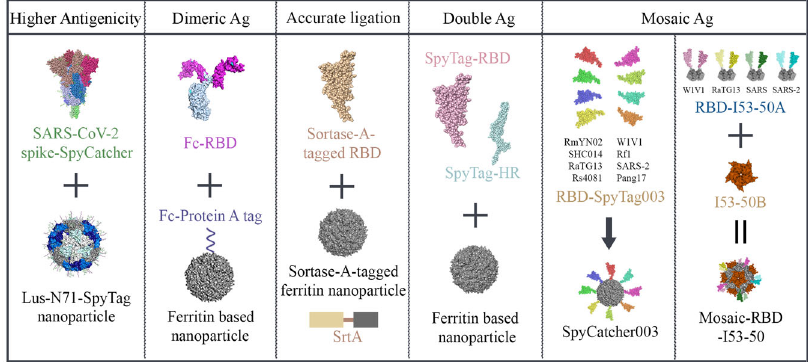
Fig. 4 Overview of antigens presented by nanoparticles. Plug-and-play platform increases the ef fi ciency of protein subunit vaccine production. Aquifex aeolicus lumazine synthase (LuS) is chosen as a scaffold to induce signi fi cantly higher neutralizing responses. The RBDs fused with an Fc tag forms an antigen dimer automatically, enabling rapid generation of vaccines targeting to variants. Sortase-A (Srt-A) is chosen for accurately ligating antigens onto nanoparticles. More than one antigen can be assembled onto the same ferritin nanoparticle using SpyTag, SpyTag003 or I53-50A, which can induce cross-reactive immunity against other coronaviruses or Sarbecoviruses . SARS SARS-CoV, SARS-2